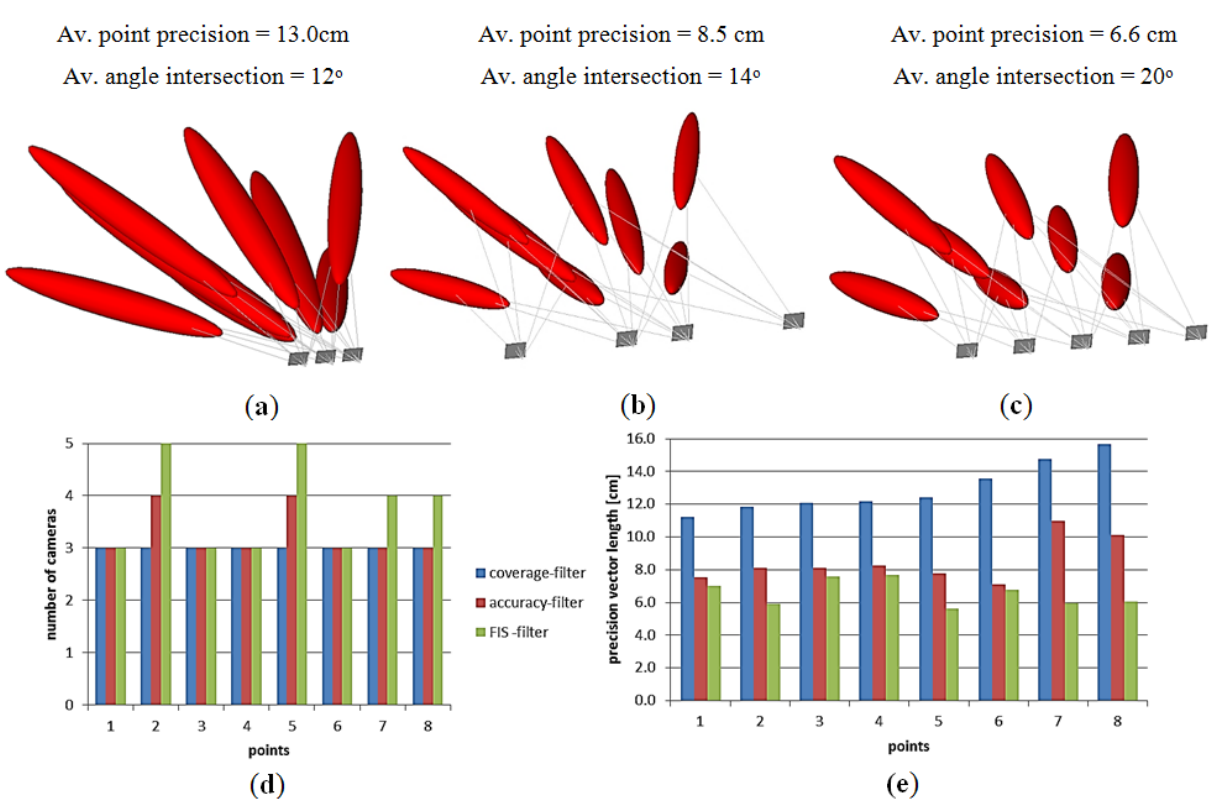
Figure 9. The minimal networks and the estimated error ellipsoid. ( a ) Filtered for coverage; ( b ) Filtered for accuracy; ( c ) Filtered by FIS; ( d ) The histogram of imaging cameras; ( e ) Histogram of